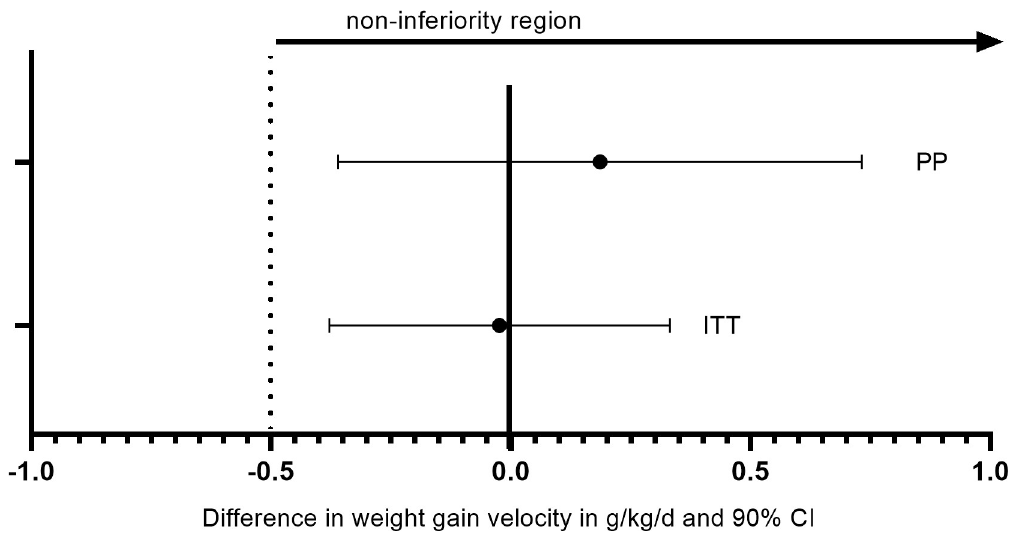
Fig 2. Difference in mean weight gain velocity (g/kg/day and 90% CI) in children with SAM randomised to reduced dose compared with standard dose in ITT and PP confirming non-inferiority. ITT, intention to treat; PP, per protocol; SAM, severe acute malnutrition.